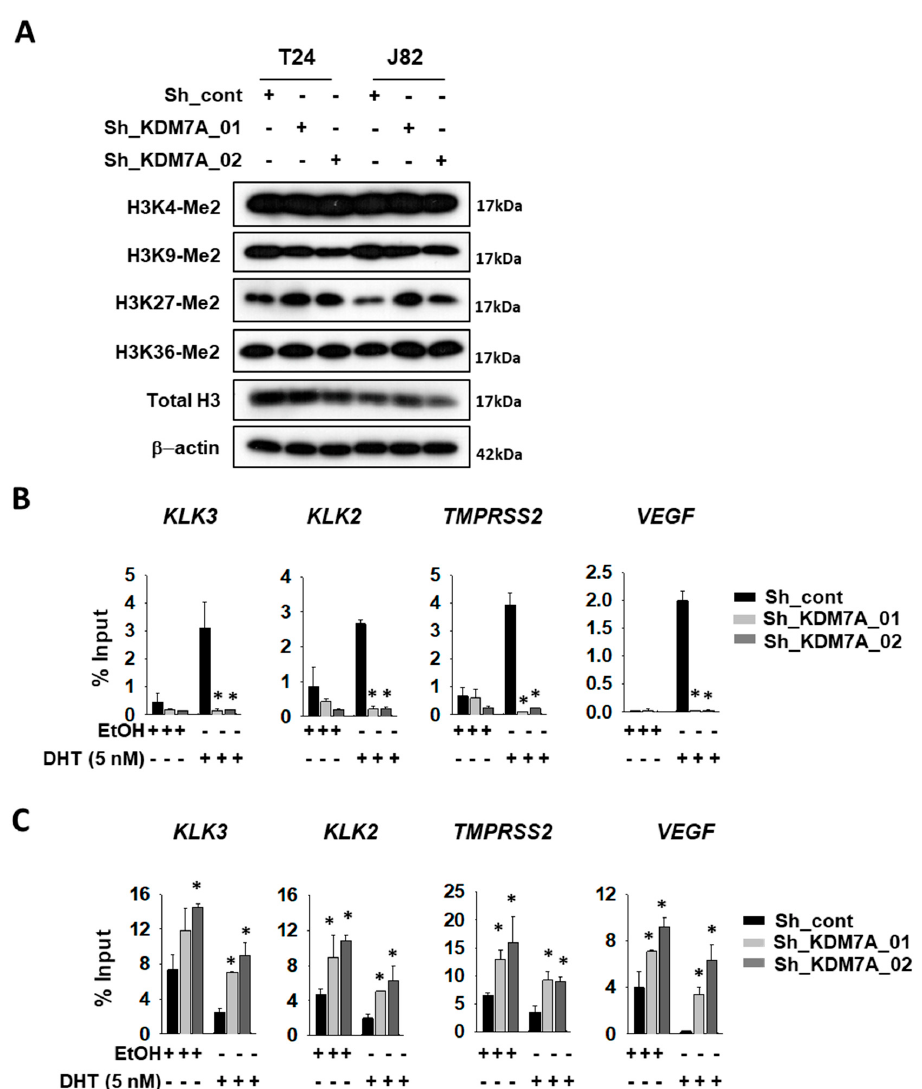
Figure 2. KDM7A directly binds on androgen receptor (AR) downstream gene promoters, and regulates H3K27 methylation. ( A ) Histone methylation status in KDM7A knock-down cells was analyzed with the indicated antibodies. T24 cells expressing control or KMD7A shRNA were treated with 5 nM DHT for 1 day, and the sonicated chromatins were immune-precipitated with anti-AR ( B ) or anti-H3K27 di-methyl ( C ) antibody. Immunoprecipitated DNAs were subjected to qPCR with the indicated gene promoter sequence primers. Bars represent means ± SD of three independent experiments. * p < 0.05 (Student’s t -test), versus the control shRNA (sh-cont) group.